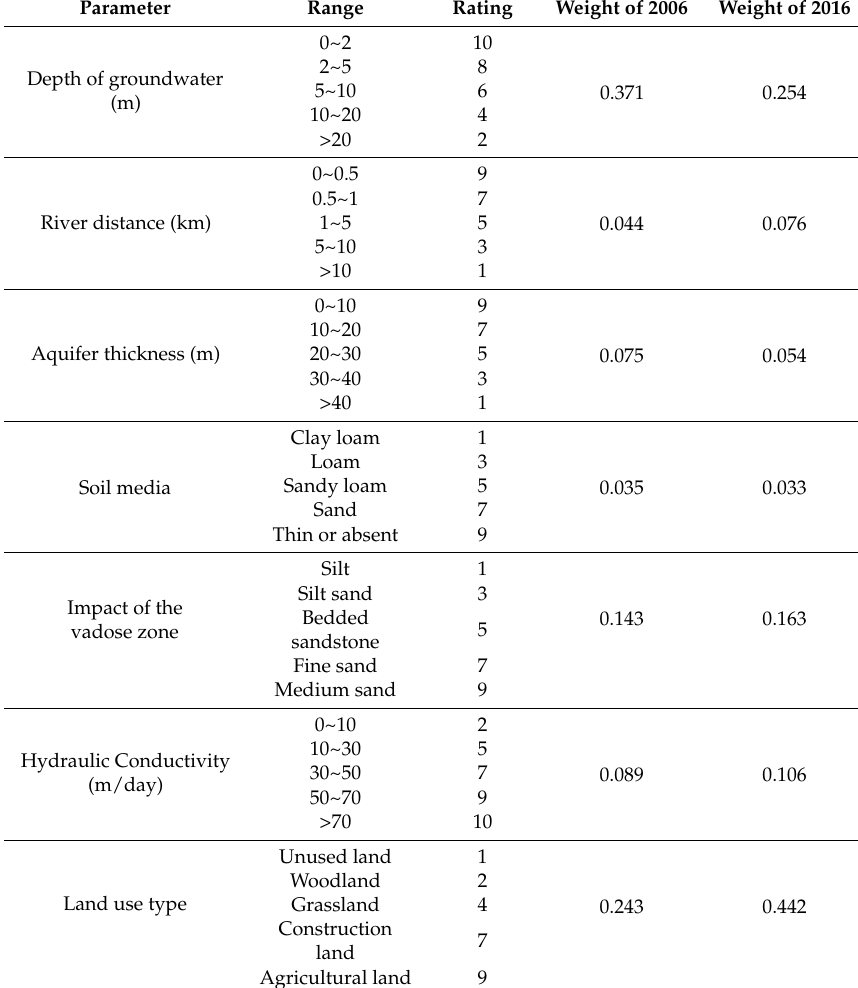
Table 2. Rating and weight scheme of DRASICL parameter